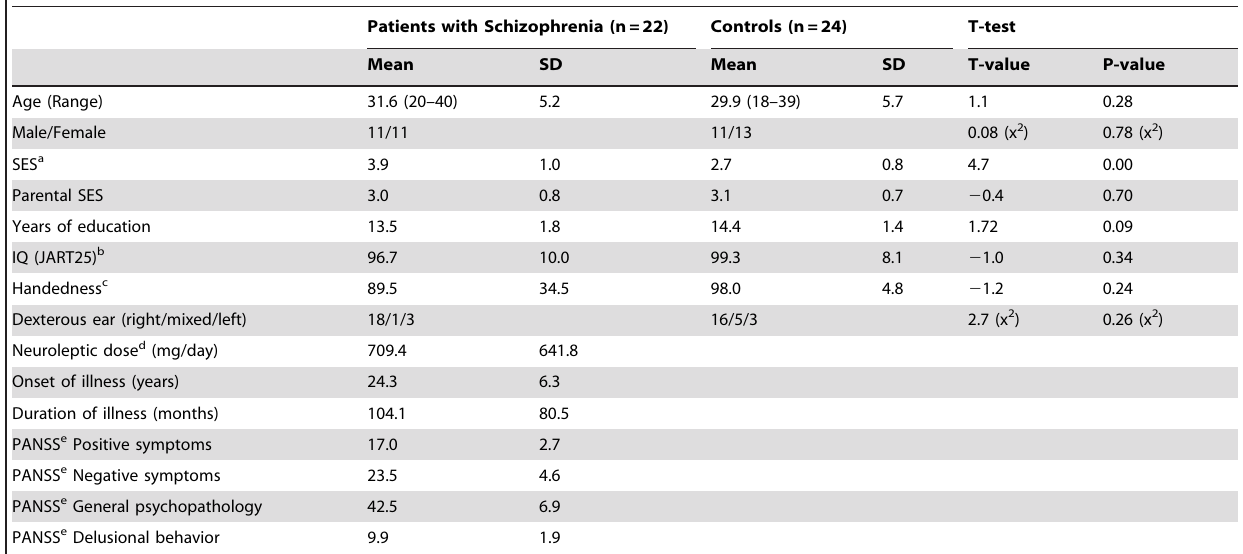
Table 1. Subject characteristics and symptom